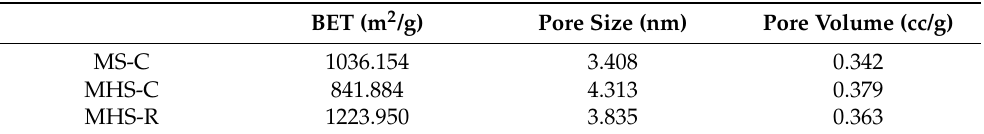
Figure 4. N 2 -adsorption-desorption isotherm graphs of mesoporous silica and mesoporous hollow silica materials.